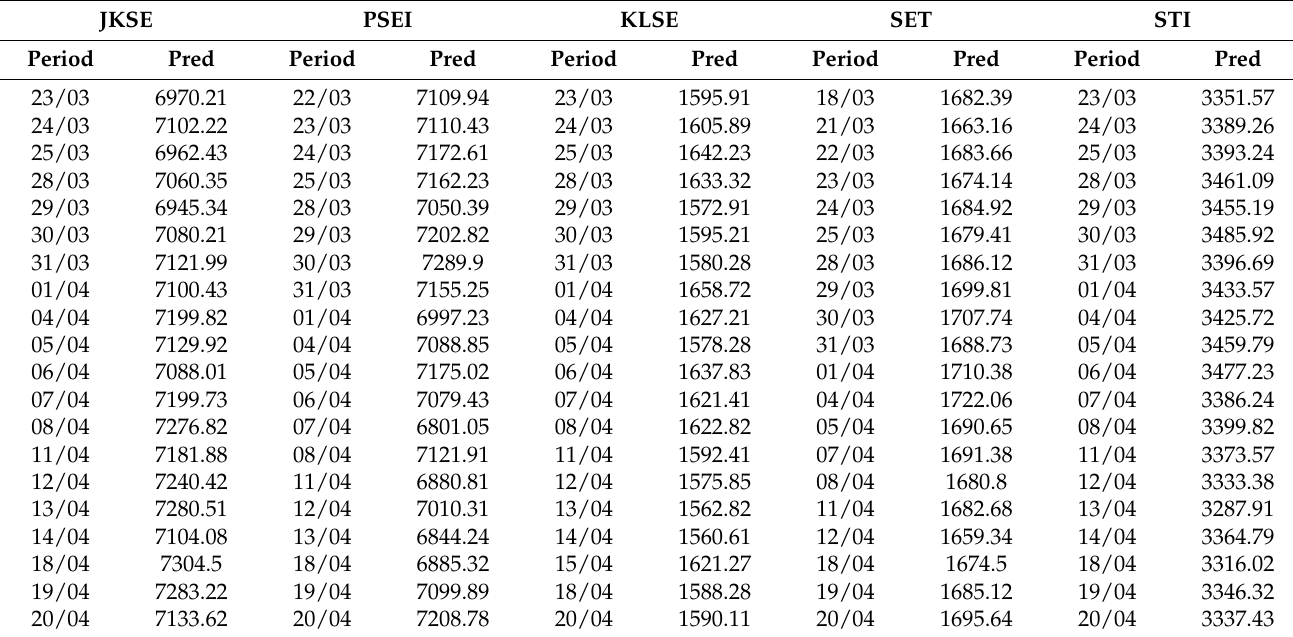
Table 7. ASEAN top 5 stock price index predictions using GBM-MCS with 5000